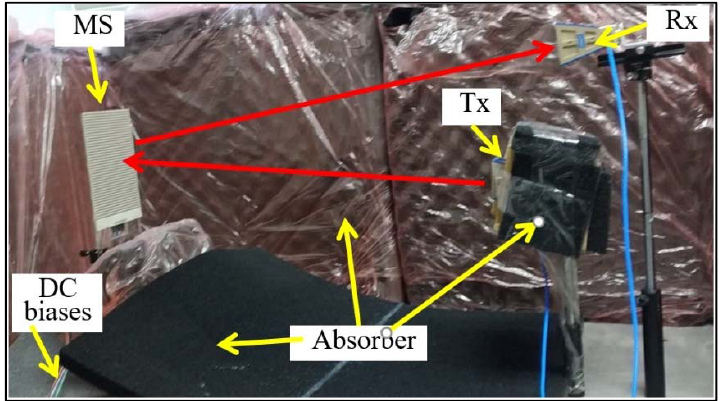
Figure 9. The reflection measurement setup.